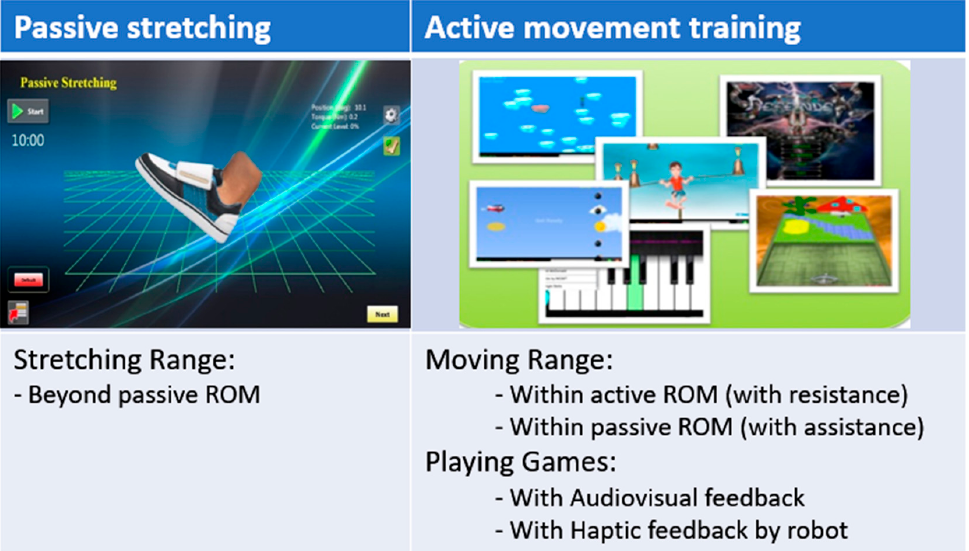
Figure 2. Schematic representation of the training session. Participant of children with CP performed passive stretching (20 min/session) and active movement exercise (20 to 30 min/session) therapy using an ankle rehabilitation robot (3 sessions/week over 6 weeks, total of 18 sessions).